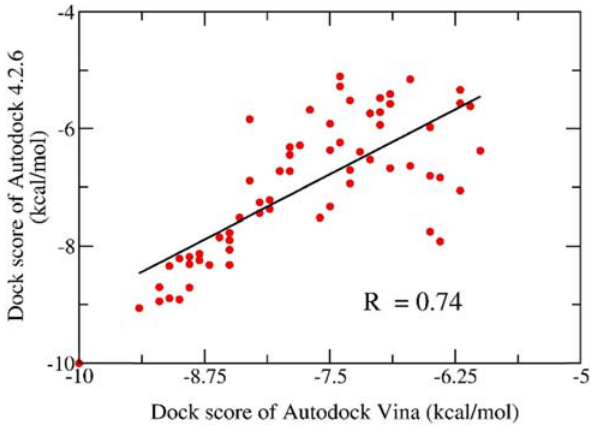
Figure 2: Correlation graph between dock score of AutoDock4.2.6 and AutoDock Vina.